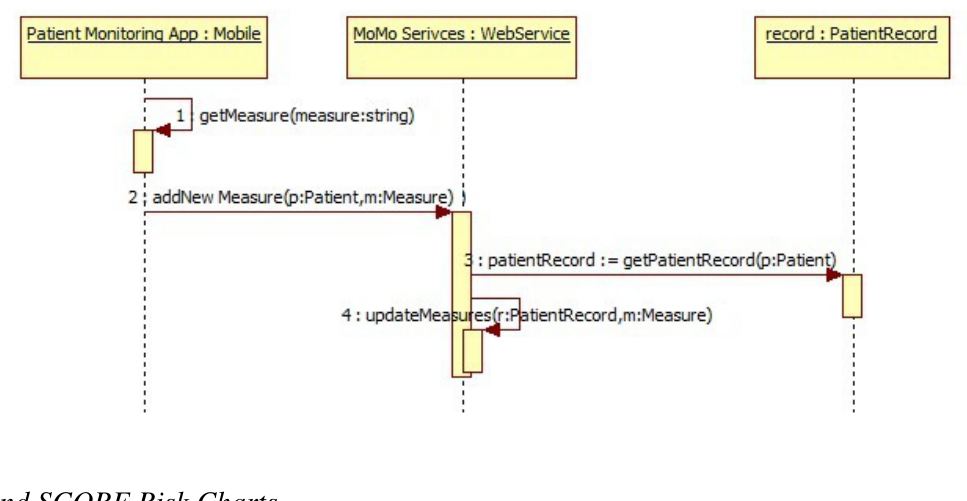
Figure 1. Sequence diagram: A new measure of blood pressure has been taken.